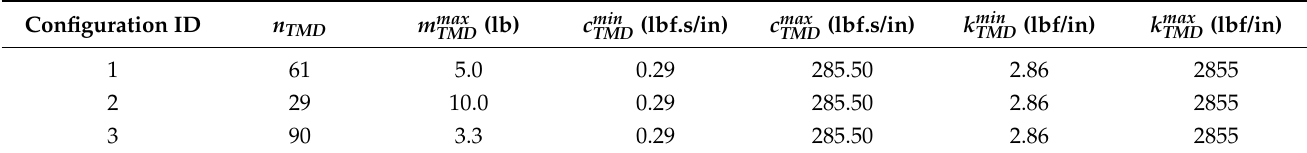
Table 3. Design variable bounds for each configuration